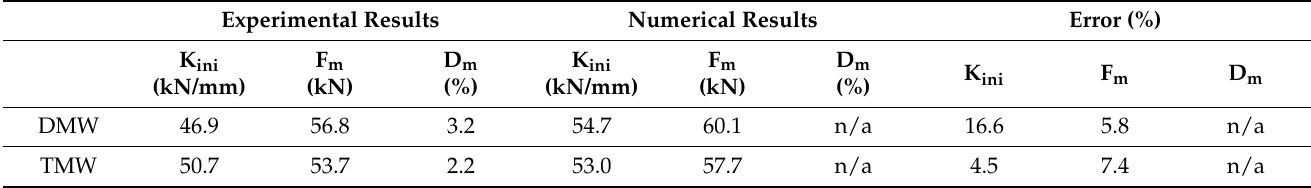
Figure 11. Comparison of experimental cracks ( a – c ) and the principal strains ( d – f ) corresponding to limit states determined for the DMW. Table 5. Numerical and experimental results in terms of initial stiffness (Kini), ultimate lateral load (Fm) and drift capacities